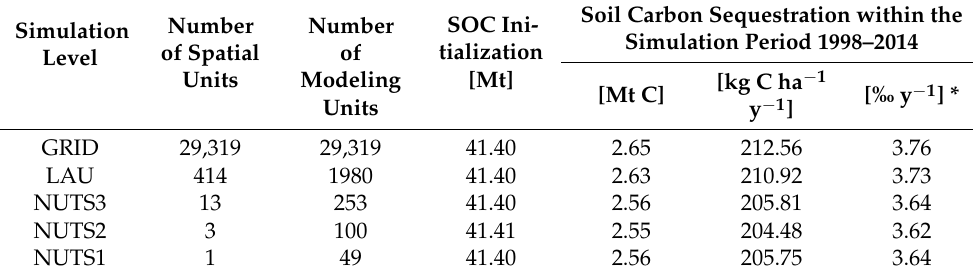
Table 2. Overview of model complexities and general trends in SOC dynamics of the Saxon arable land (NUTS1 region) simulated for the reference period (1998–2014). A grid-based reference set-up is compared with four upscaled model set-ups simulating SOC dynamics at the level of administrative